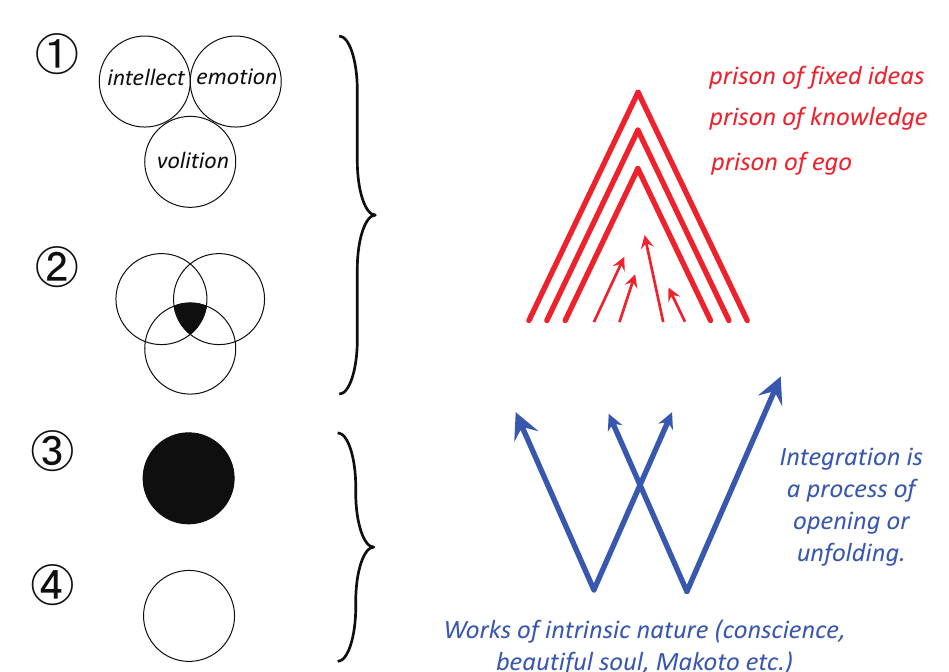
Figure 4. A schematic diagram of the process of integration. The symbol 1 (cid:13) shows the state when intellect, emotion, and volition are separated. The symbols 2 (cid:13) and 3 (cid:13) show the states of intellect, emotion, and volition when synthesized. The symbol 4 (cid:13) shows the state of intellect, emotion, and volition when integrated. The concept of intellect, emotion, and volition can be replaced with other concepts such as goodness, truth, and